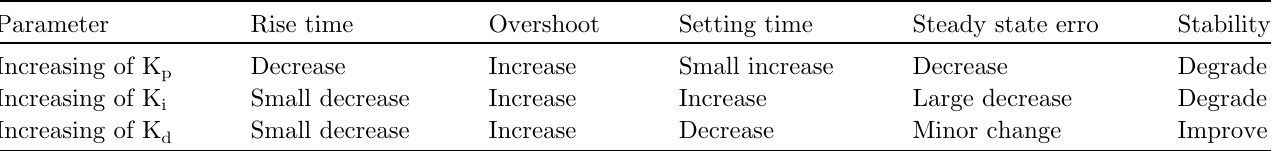
Fig. 6. PID control schematic diagram. Table 4. PID controller regulation characteristics